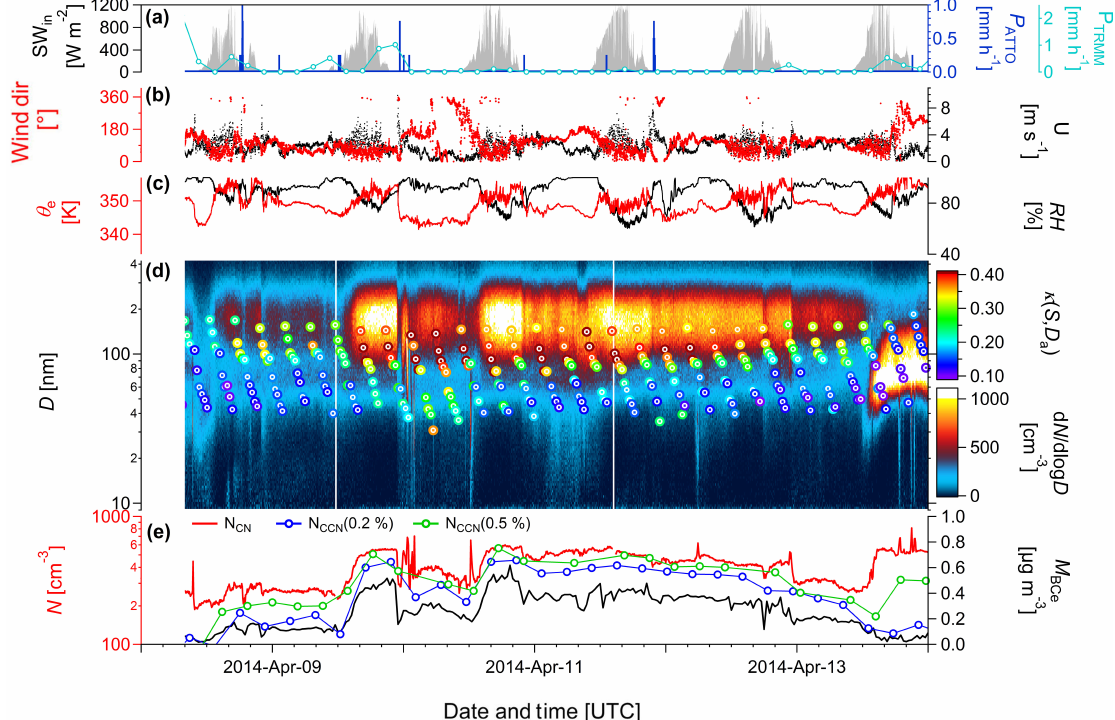
Figure 7. Selected meteorological, aerosol, and CCN time series from ATTO measurements for the long-range-transport (LRT) study period (see Fig. 3). (a) Incoming shortwave radiation, SW in ; precipitation rates from TRMM satellite mission, P TRMM ; and in situ measurements at ATTO, P ATTO . (b) Wind direction and wind speed, U , at ATTO. (c) Equivalent potential temperature, θ e , and relative humidity, RH, at ATTO. (d) Overlay of two data layers showing aerosol number size distribution contour plot, d N /dlog D , as well as color-coded markers, representing time series of κ(S,D a ) size distributions. (e) CCN concentrations, N CCN (S ), for two selected S levels; total aerosol number concentration, N CN , 10 ; and BC e mass concentration, M BC e